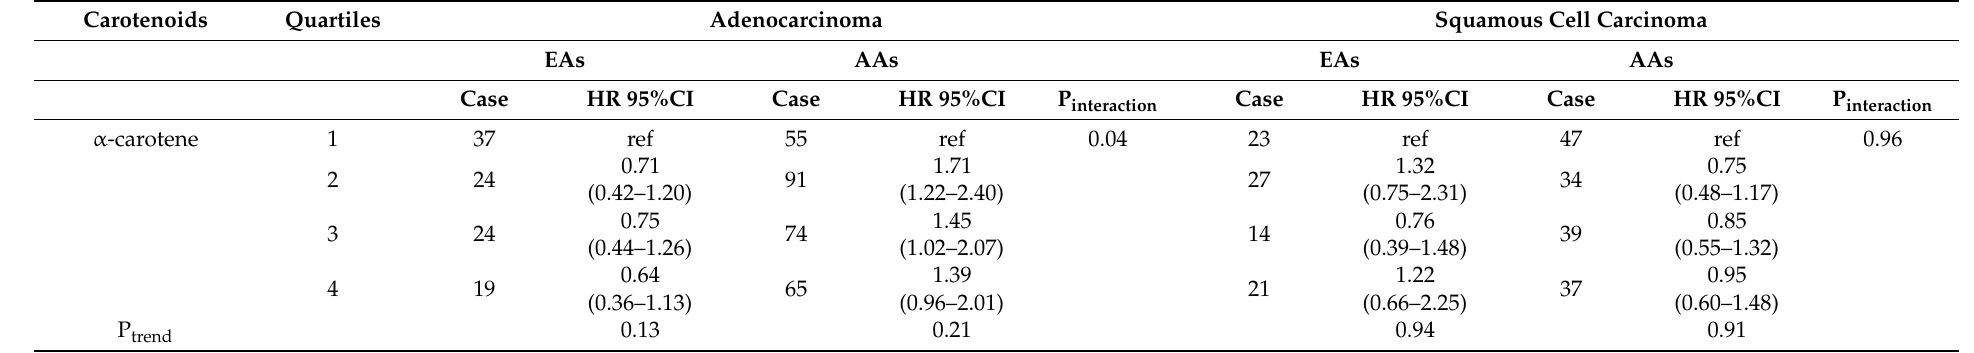
Table 5. The associations of dietary carotenoids and vitamin A intakes with risk of adenocarcinoma and squamous cell carcinoma lung cancer by race,